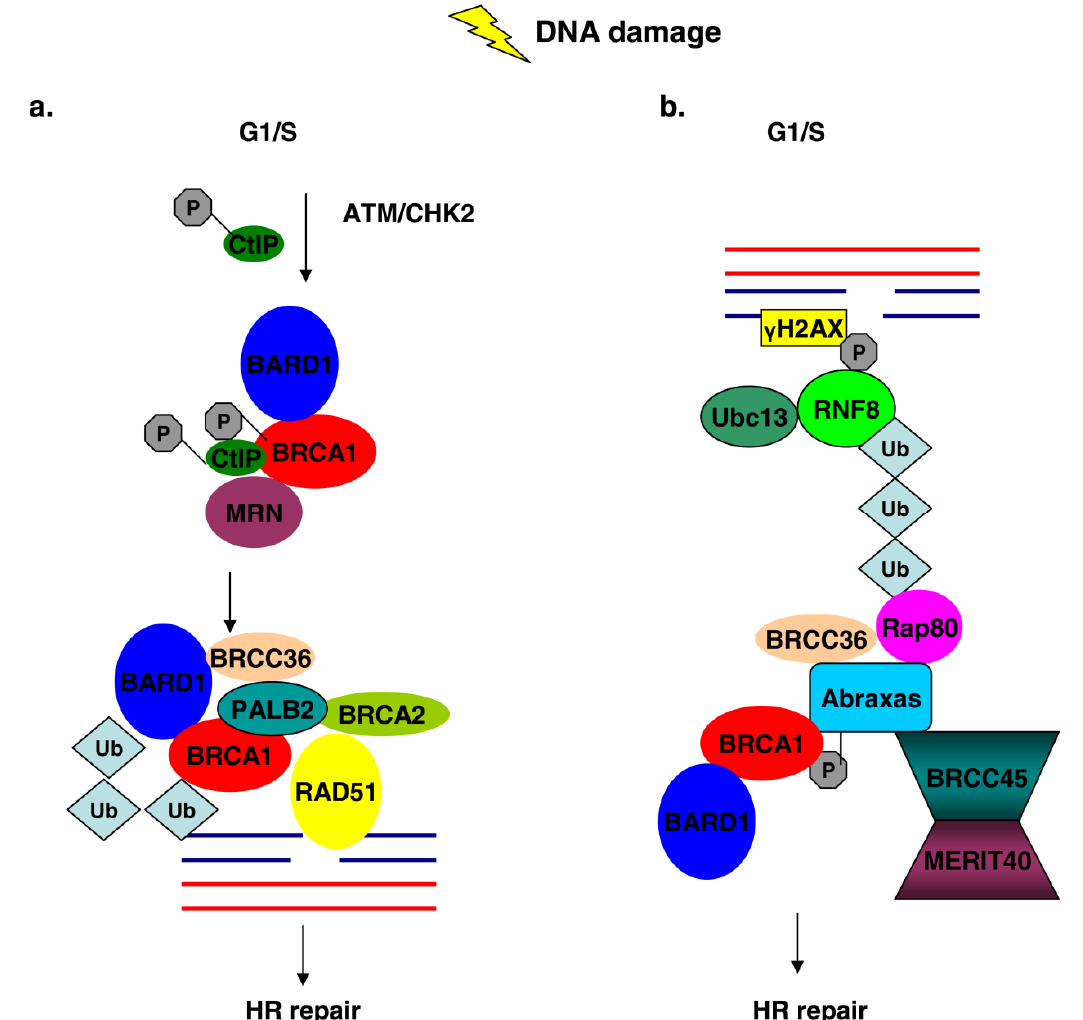
Figure 3. BRCA1 association with different protein complexes during the G1/S phase of the cell cycle regulates HR repair mechanisms in response to DNA damage. ( a ) DNA damage activates ATM and CHK2 kinases, which mediate phosphorylation of CtIP and BRCA1. Phosphorylated CtIP associates with BRCA1 and with the MRN complex leading to the recruitment of the BRCC complex at the site of DNA damage where HR is